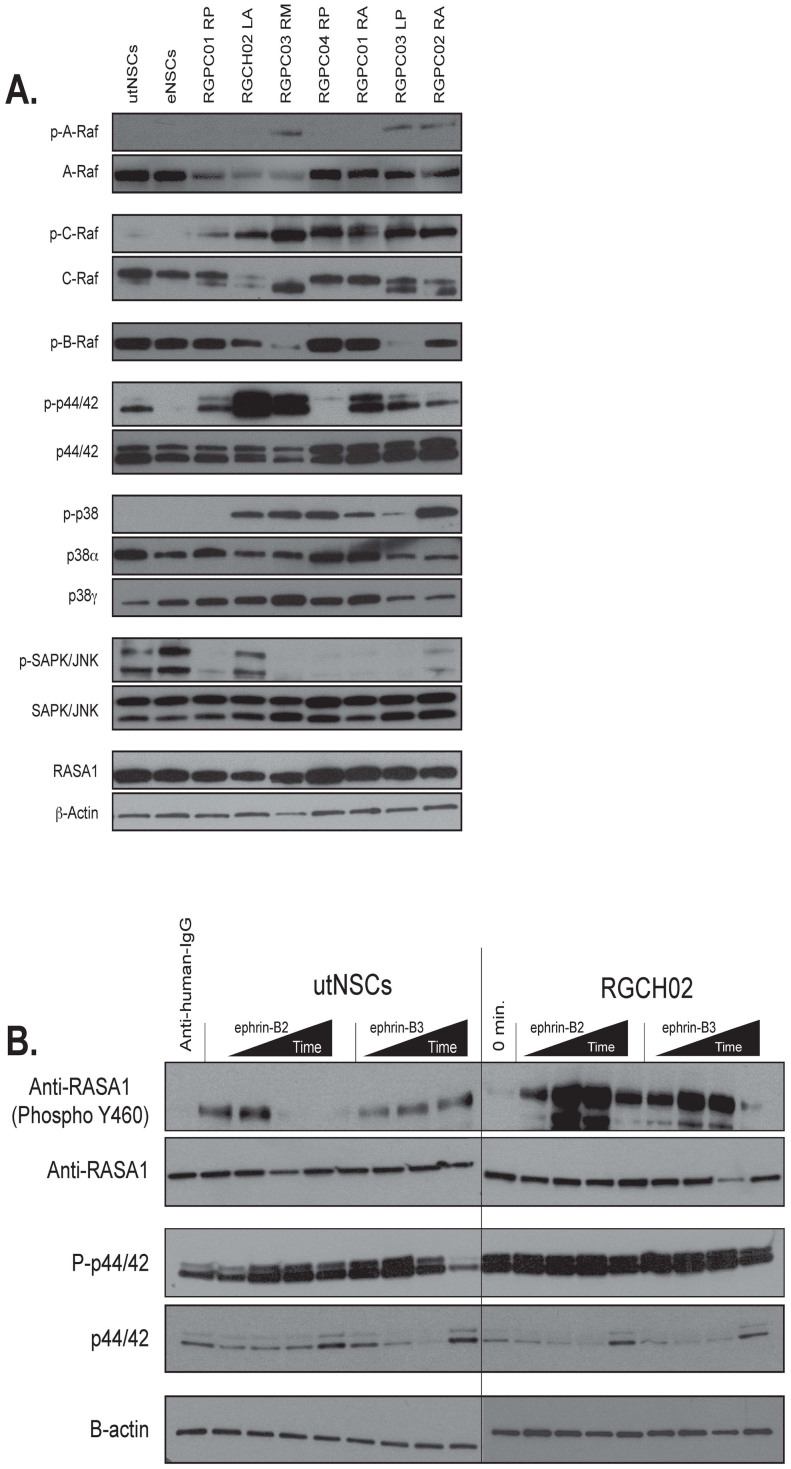
EphB2 driven tumor cell lines exhibit a different phosphoprotein expression pattern then utNSCs independent of receptor activation.(a) Western blot analysis of total and phosphorylated protein expression in utNSCs, Ink4a/Arf(−/−) STeNSCs (lane labeled eNSC) and seven tdNSC lines for signaling proteins involved in Ras (A-Raf, B-Raf, C-Raf, Mek1/2, and p44/42, RASA1), p38 MAPK (p38α and p38γ) and SAPK/JNK. Western blot analysis of p44/42 (b) and RASA1 (c) phosphorylation after in vitro utNSCs or RGCH02 initial EphB2 activation with anti-human-IgG (negative control) or 15, 30, 60, and 120 minute treatment with either ephrin-B2 or ephrin-B3.